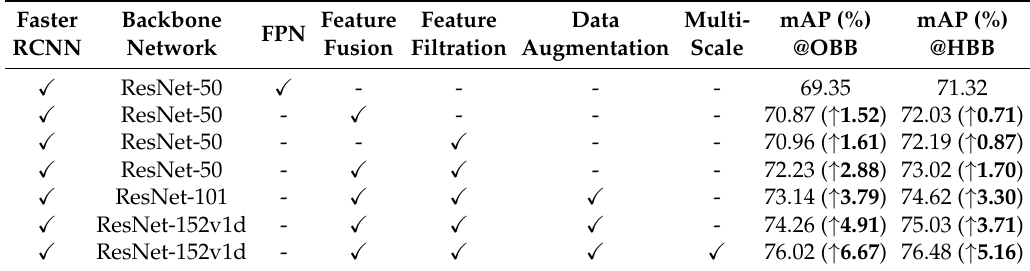
Table 6. Ablation study of components on DOTA